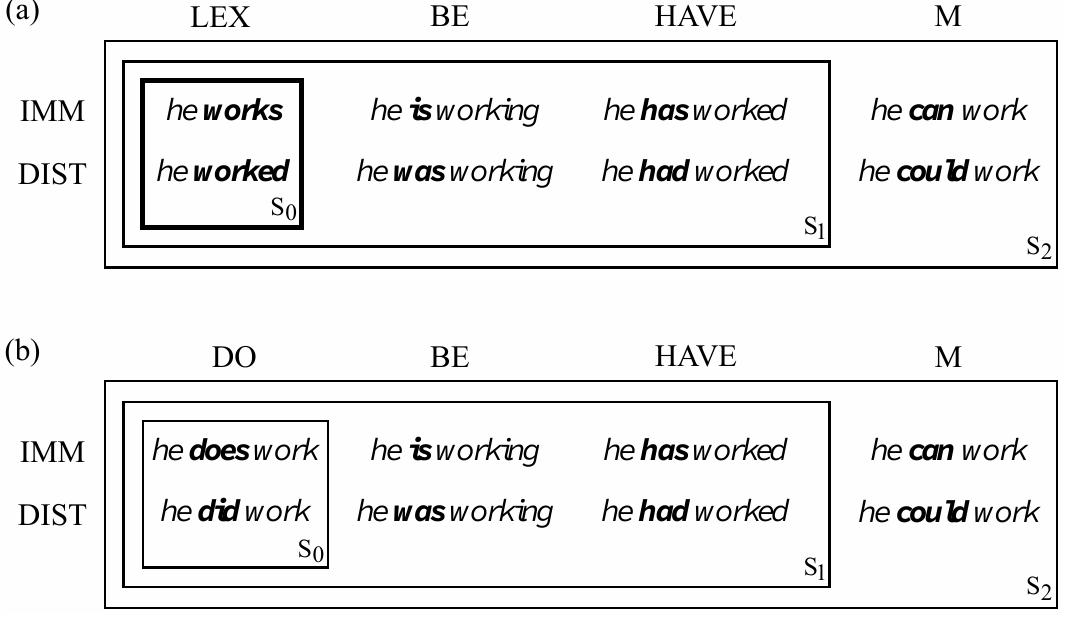
Figure 4. Summary of options for the finite verb.